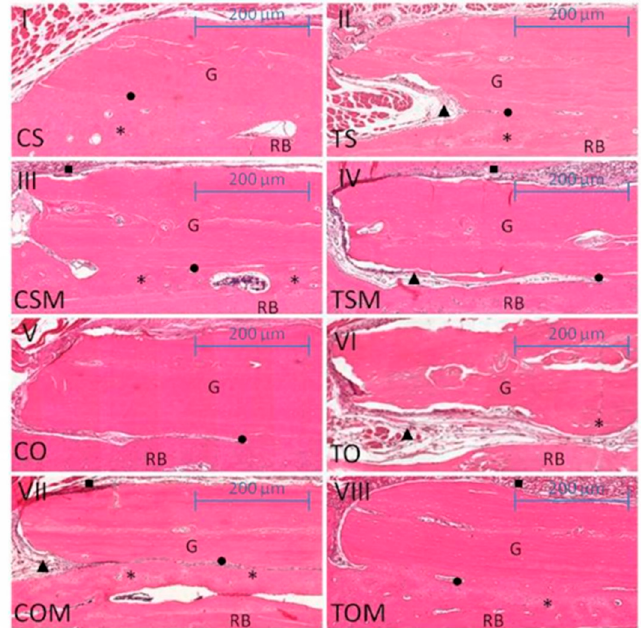
Figure 2. Scanned images for histomorphometric analysis of 60 days. I ) subgroup non-smoking and SHAM (CS); II ) subgroup smoking and SHAM (TS); III ) subgroup non-smoking, SHAM and graft combined with collagen membrane (CSM); IV ) subgroup smoking, SHAM and graft combined with collagen membrane (TSM); V ) subgroup non–smoking and ovariectomized (CO); VI ) subgroup smoking and ovariectomized (TO); VII ) subgroup non-smoking, ovariectomized and graft combined with collagen membrane (COM); VIII ) subgroup smoking, ovariectomized and graft combined with collagemn membrane (TOM). G = graft; RB = receiver bed; ● integration; ▲ connective tissue; ⃰ neoformation; ■ collagen membrane. Scale 200 µm.